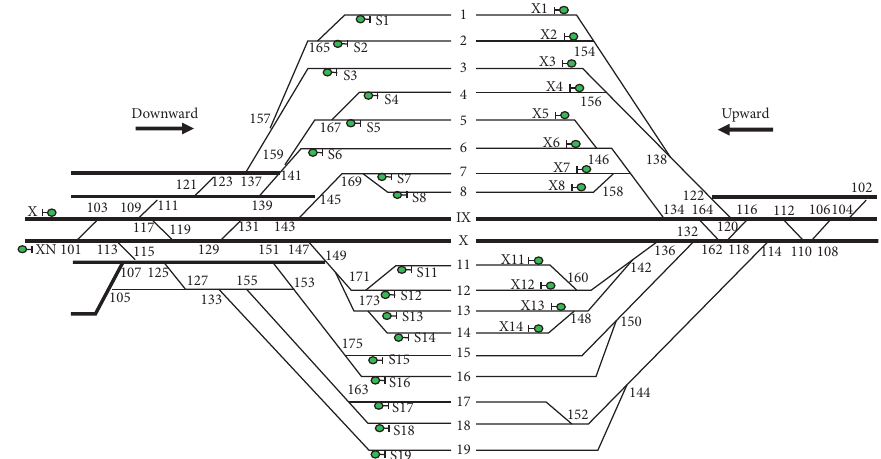
Figure 11: High-speed yard infrastructure layout of Shanghai-Hongqiao Station. Table 3: Station route information of the high-speed yard in Shanghai-Hongqiao Station. Arrival route of downward